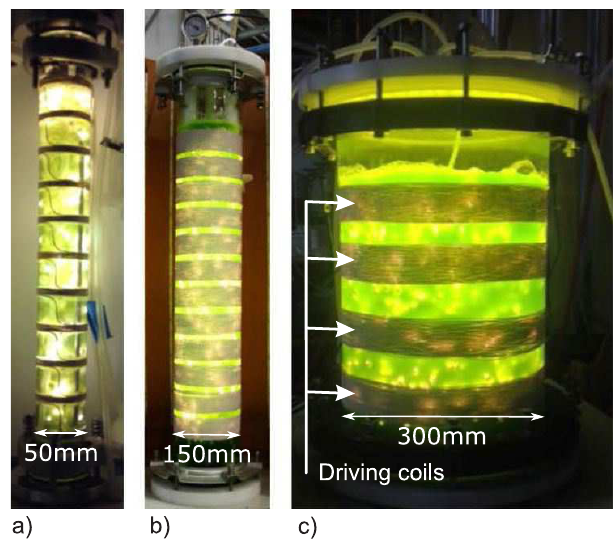
Figure 2. Three test reactors with diameters of ( a ) 50mm, ( b ) 150mm, and ( c ) 300mm. The largest reactor with the four tagged driving coils has been used in the experiments described